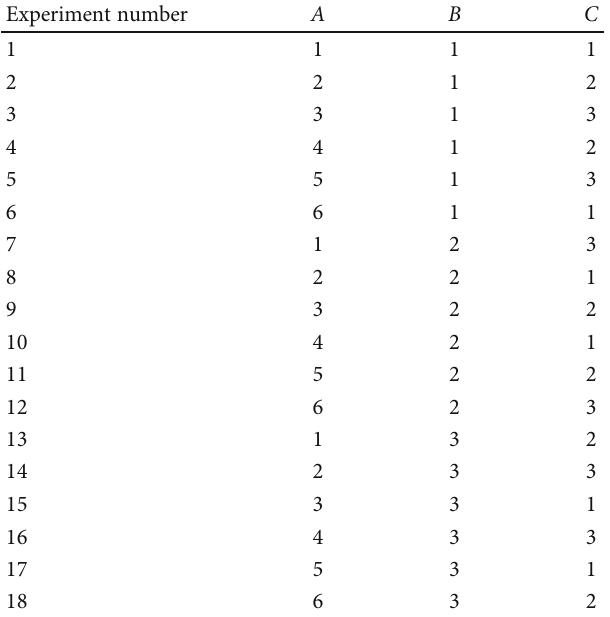
Table 5: The overall average value of experimental results.